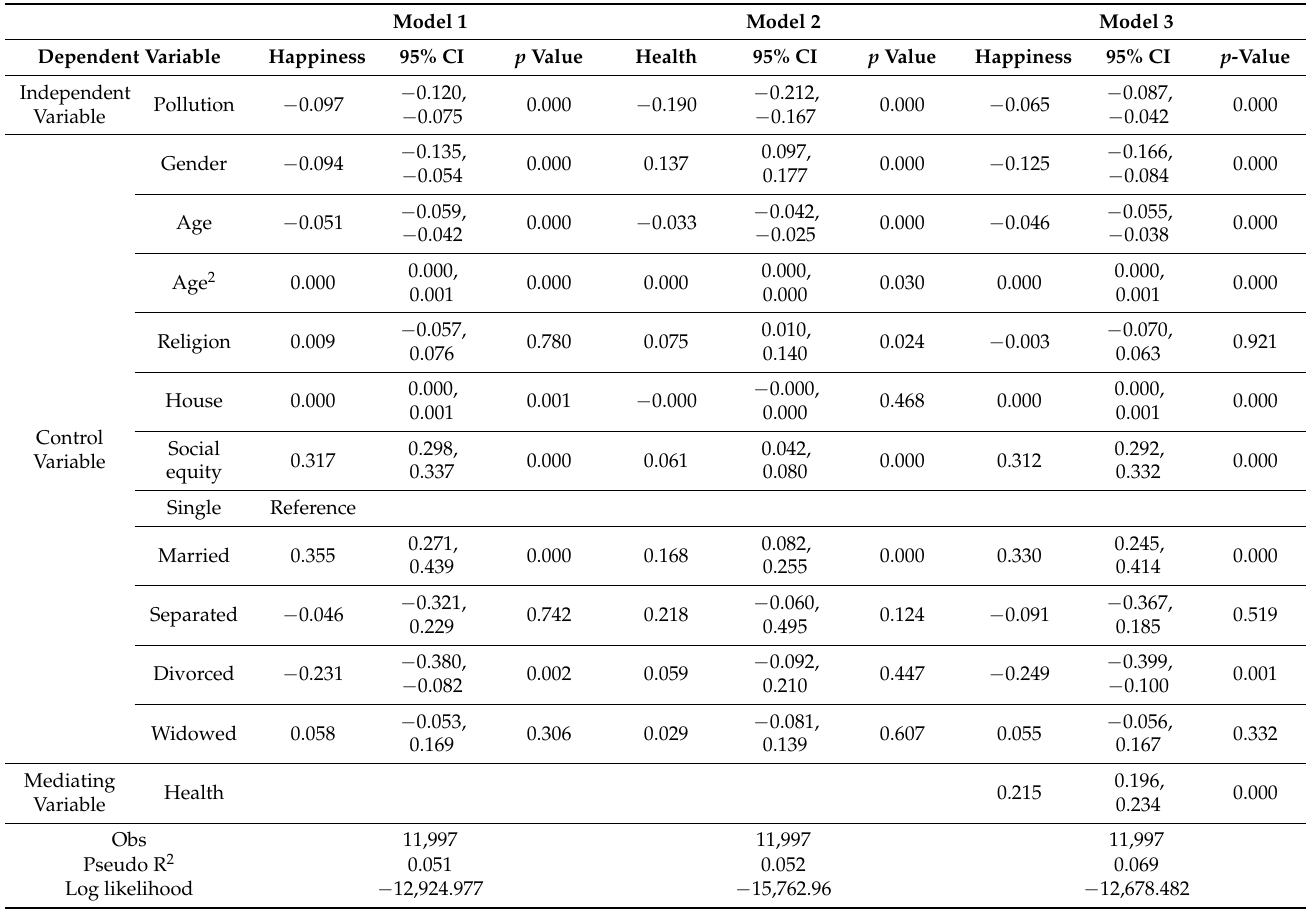
Table 2. Impacts of pollution, health on the level of happiness. Model 1 Model 2 Model